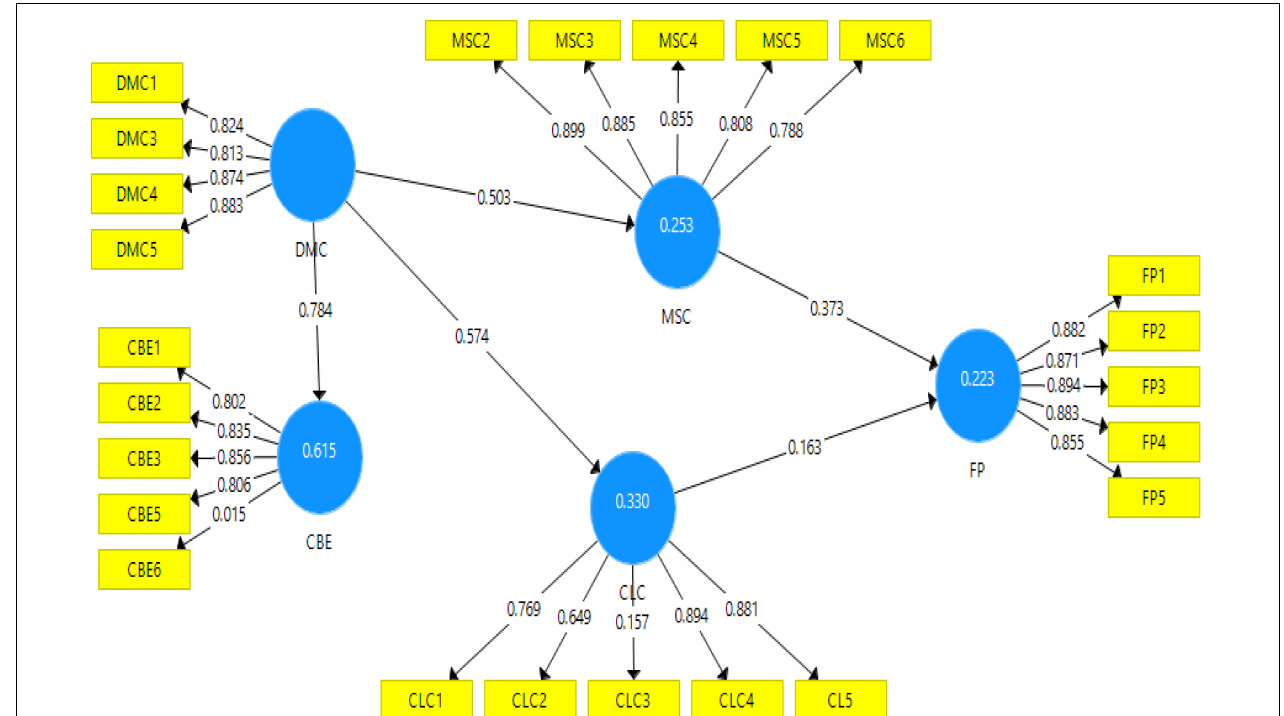
FIGURE 2 | Measurement